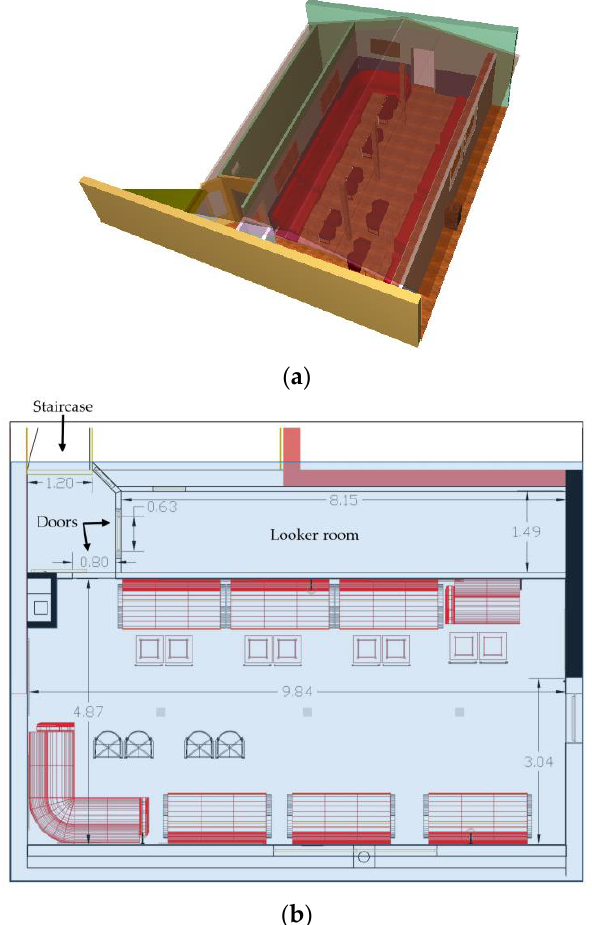
Figure 2. Virtual geometry for the first floor ( a ) — model detail; schematic graph of the first floor ( b ).